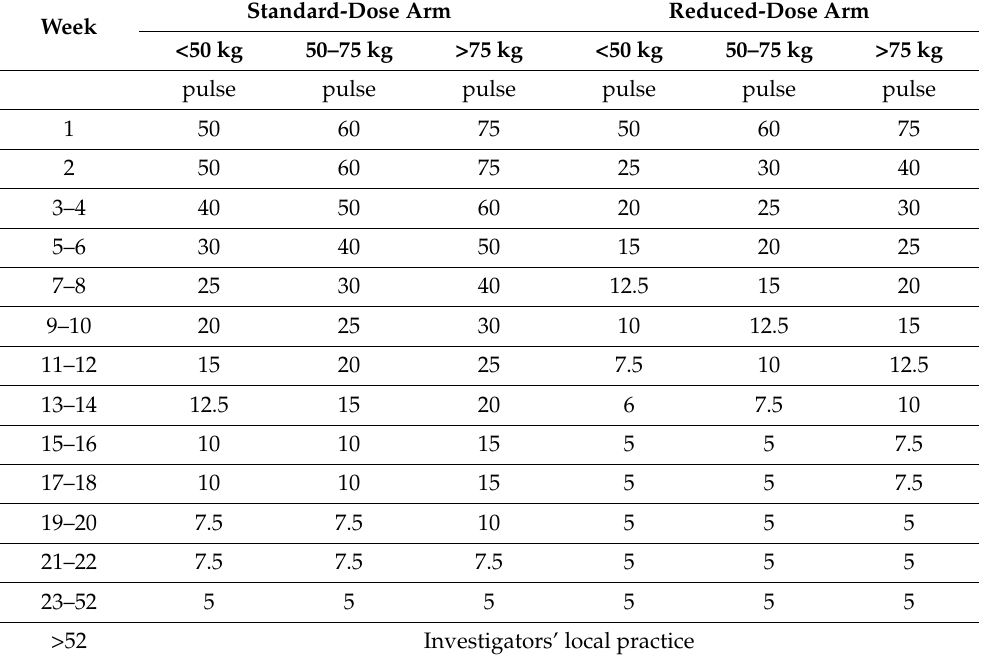
Table 3. Glucocorticoid dosing in PEXIVAS (in